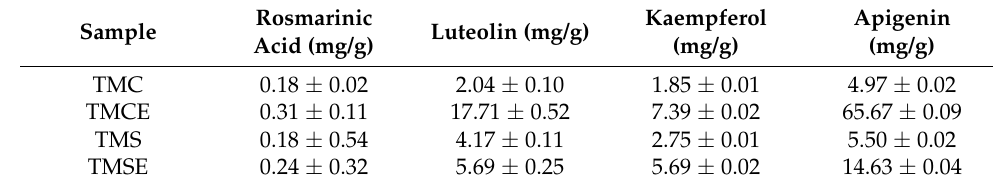
Table 2. Results obtained for the HPLC quantification of polyphenolic